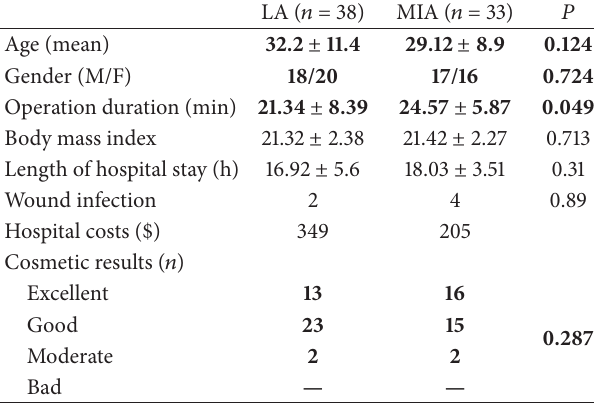
Table 1: Comparison of MIA (mini-incision appendectomy) and LA (laparoscopic appendectomy) according to postoperative com- plications, cosmetic results, and total hospital costs. The results showed no significant difference between MIA and LA, except total hospital costs. Total hospital costs of LA were higher by 58.7% when compared to